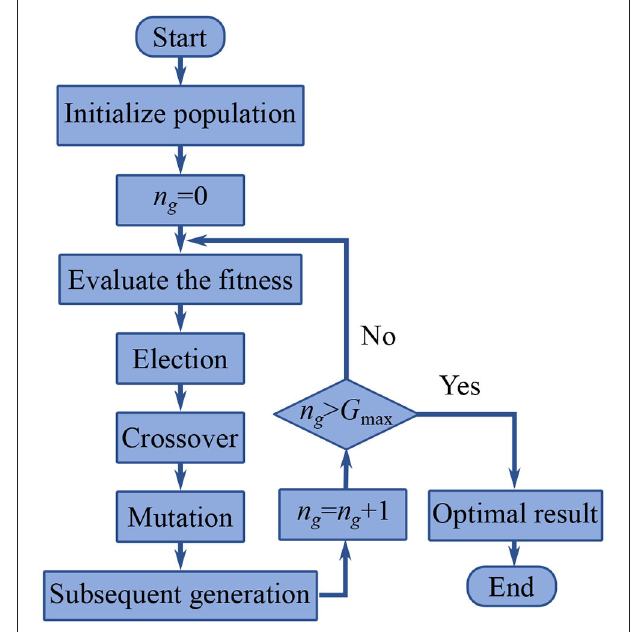
FIGURE 3 | Procedure of the genetic algorithm method.